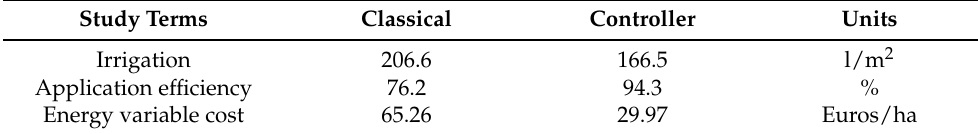
Figure 9. Soil moisture dynamics per soil layer of RTO trajectory and RTO + MPC predictive control. Table 4. Table of comparison between classical irrigation and the proposed controller in